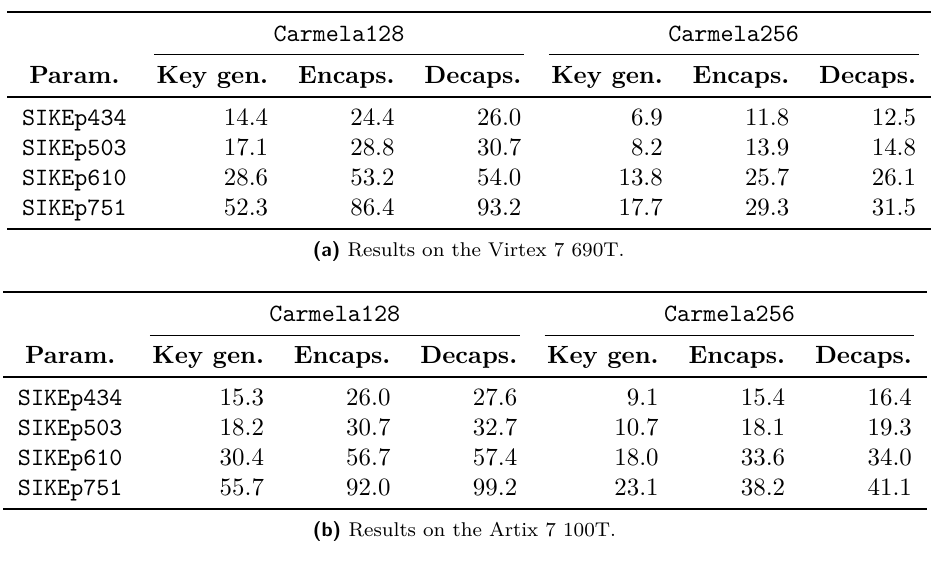
Table 1: Timing results for all SIKE parameter sets of our architecture based on Carmela128 and Carmela256 on the Virtex 7 690T and Artix 7 100T platforms, measured in milliseconds (ms).